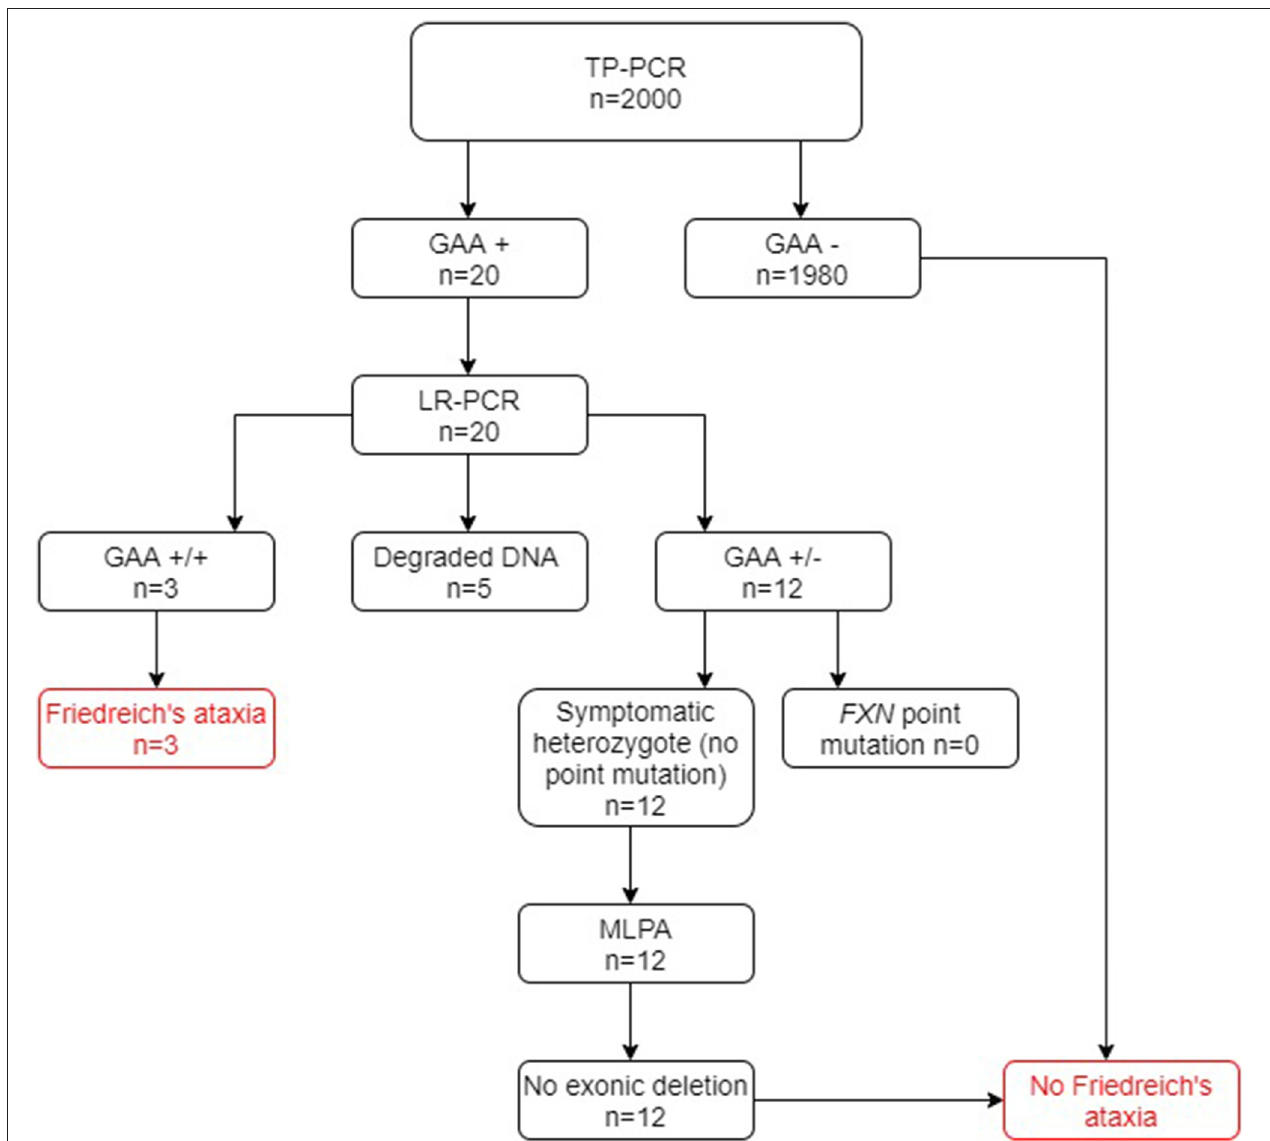
FIGURE 2 | Flowchart summary of TP-PCR and Long PCR results in group A. Out of 2,000 patients, 20 patients tested positive for presence of GAA repeats by the TP-PCR method. Out of these 20 patients, only 3 tested FRDA-positive at the Long PCR stage for GAA expansions, with 12 being confirmed as carriers and the remaining 5 giving no result. Of the 12 FRDA carriers, none tested positive for FXN point mutations or exonic deletions. GAA + / + two GAA expansions; GAA + / − one GAA expansion; GAA − / − no GAA expansions. MLPA, multiplex ligand-dependent probe